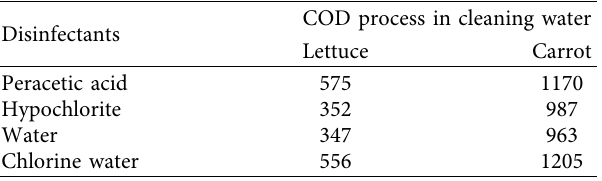
Table 2: The COD process of vegetables in clean water with disinfectants.